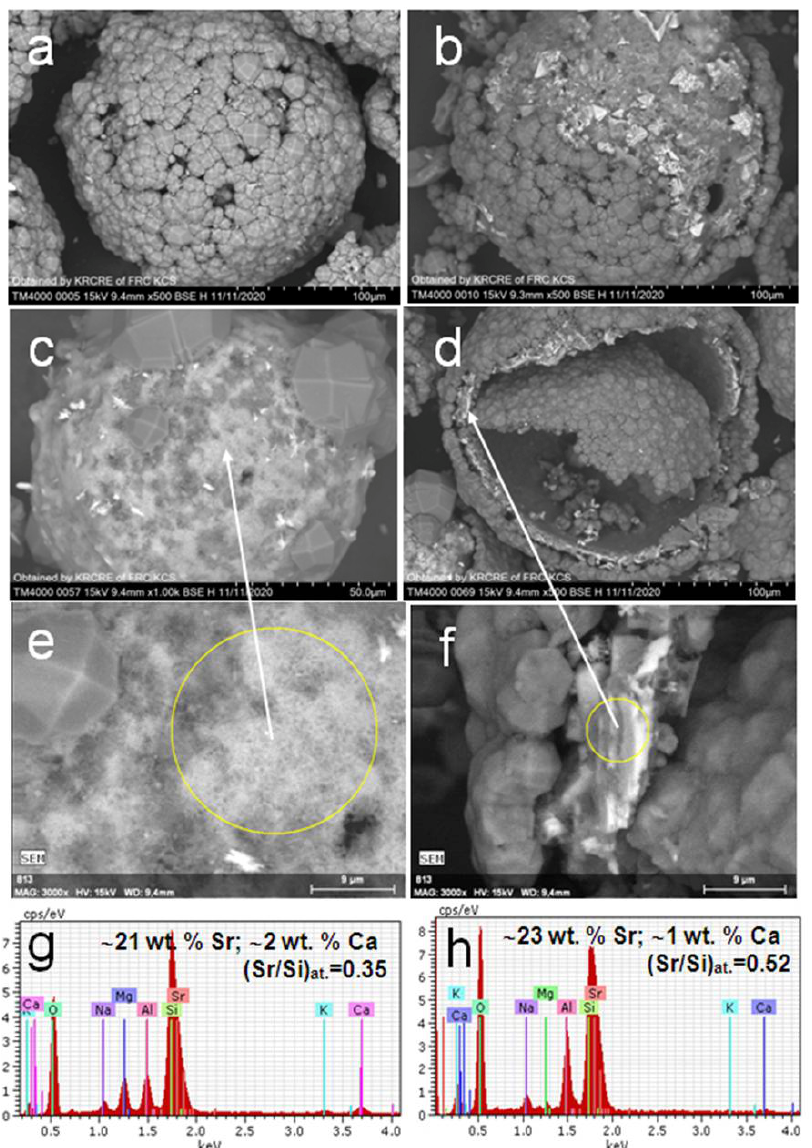
Figure 3. SEM images of product particles resulting from ( a – d ) hydrothermal crystallization in the Sr(NO 3 ) 2 -NaOH-H 2 O-(SiO 2 -Al 2 O 3 ) glass systems at 150 ◦ C; ( e – h ) BSE micrographs and associated EDX spectra for local parts of the